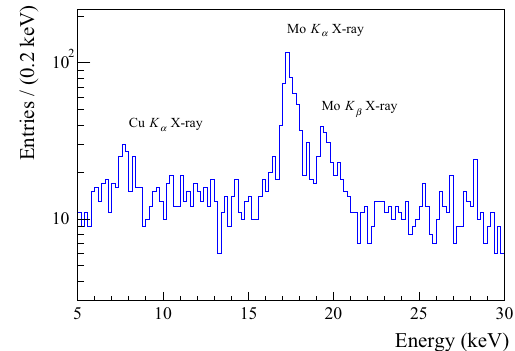
Fig. 9 Energy spectrum of CUPID-Mo light detector LD2 after a 33 h 60 Co irradiation in the EDELWEISS-III set-up. The Mo K α X-rays are used for the LD calibration